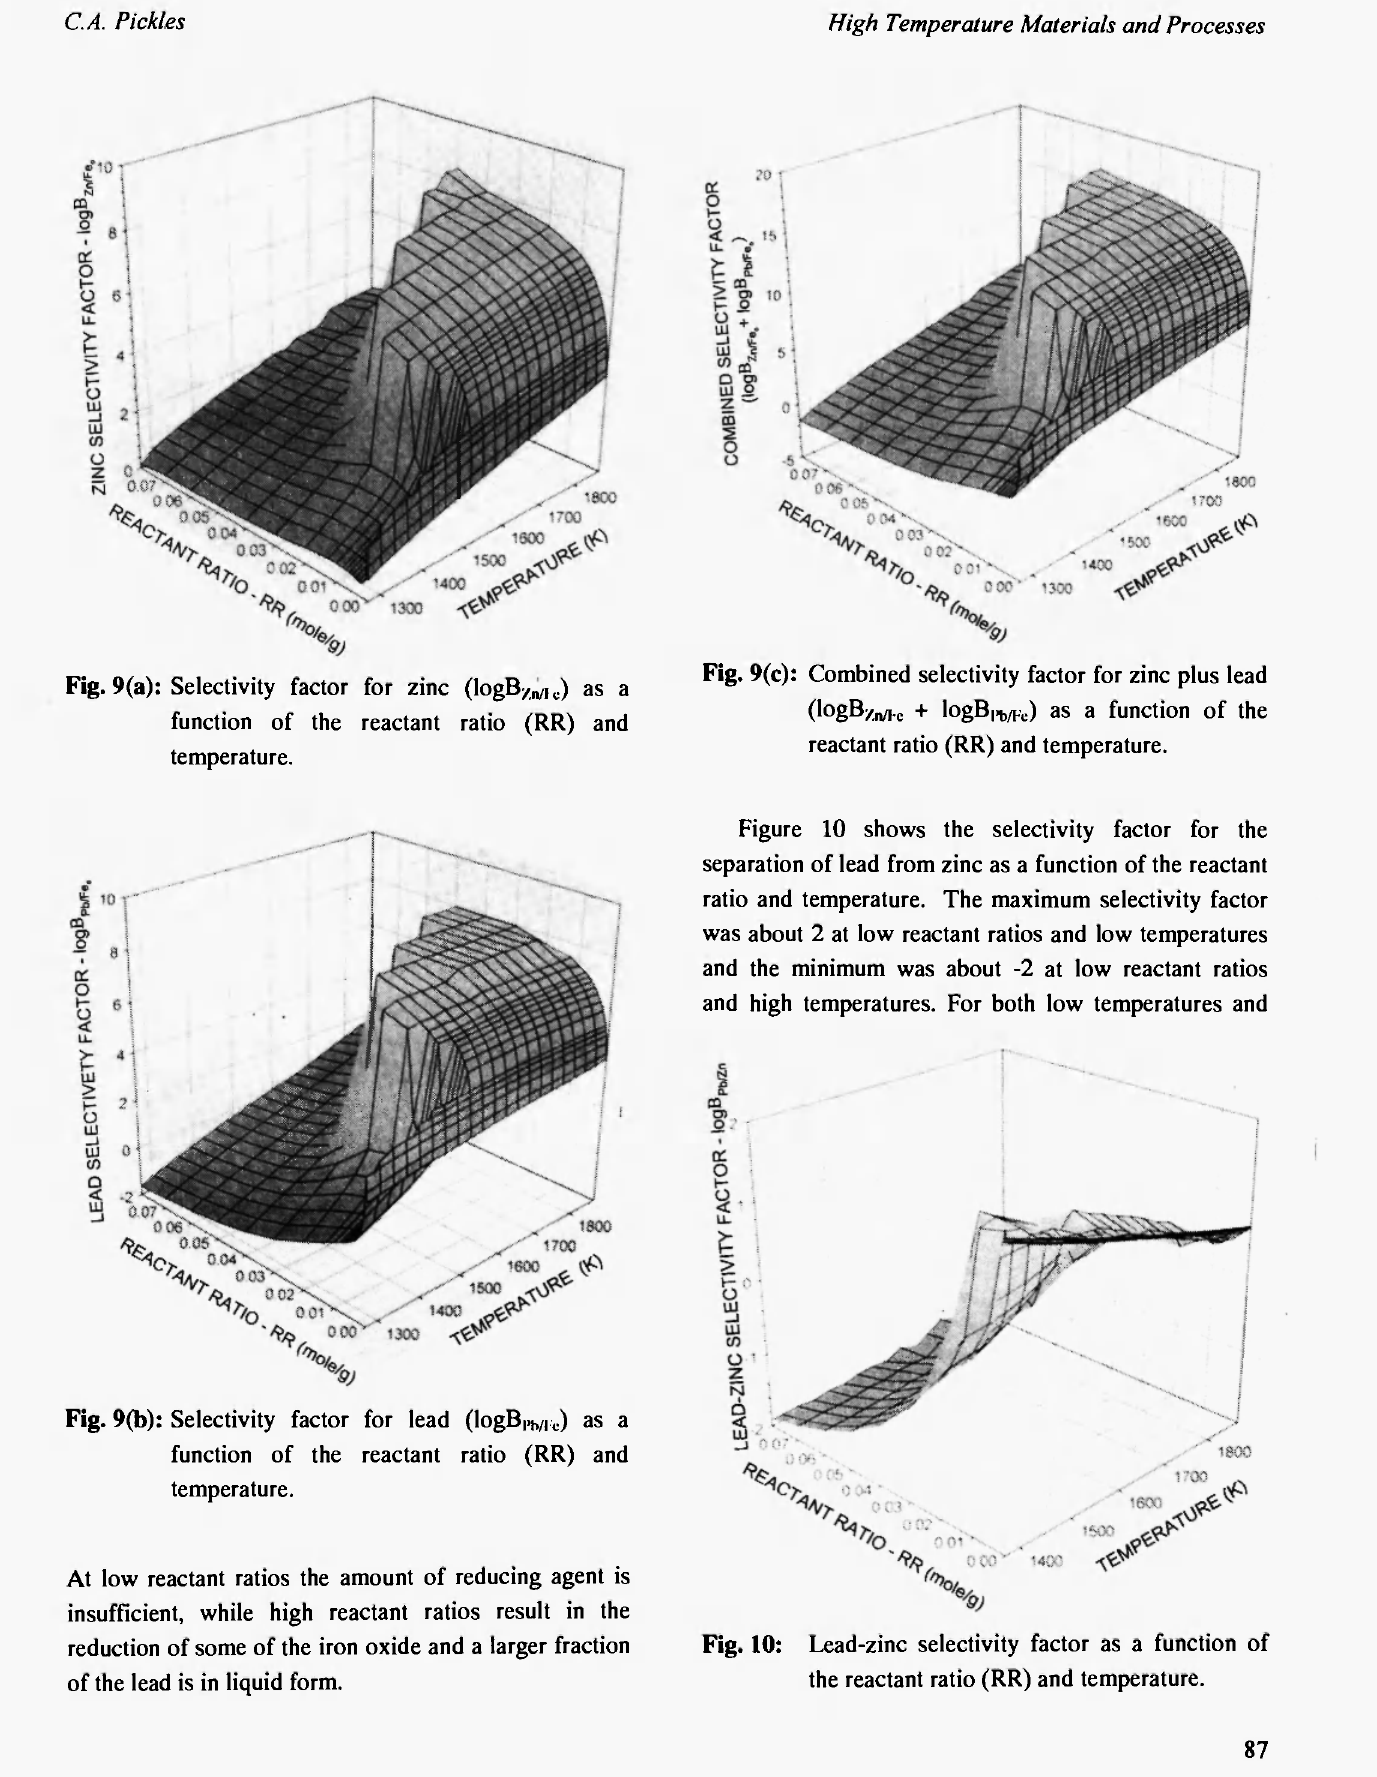
Fig. 10: Lead-zinc selectivity factor as a function of the reactant ratio (RR) and temperature.